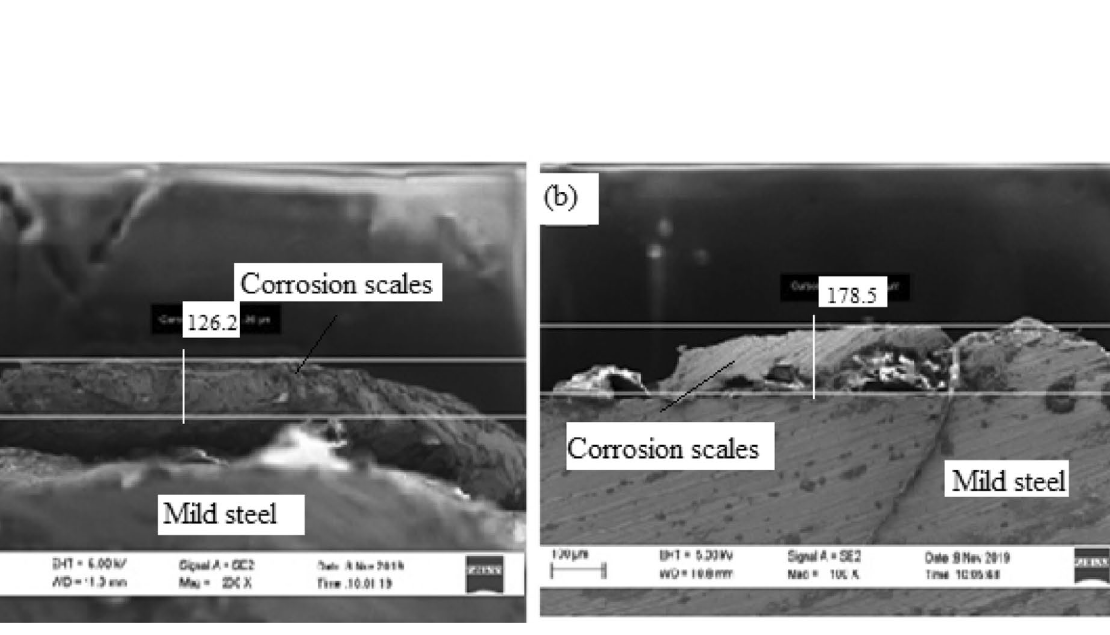
Figure 8. SEM surface view of annealed sample at 850 °C ( a ) before and ( b ) after